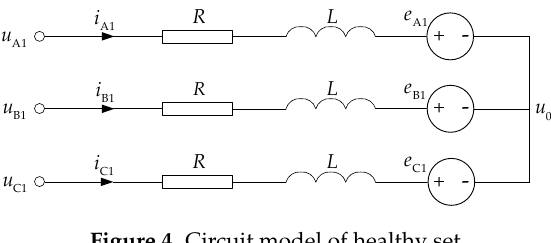
Figure 4. Circuit model of healthy set.